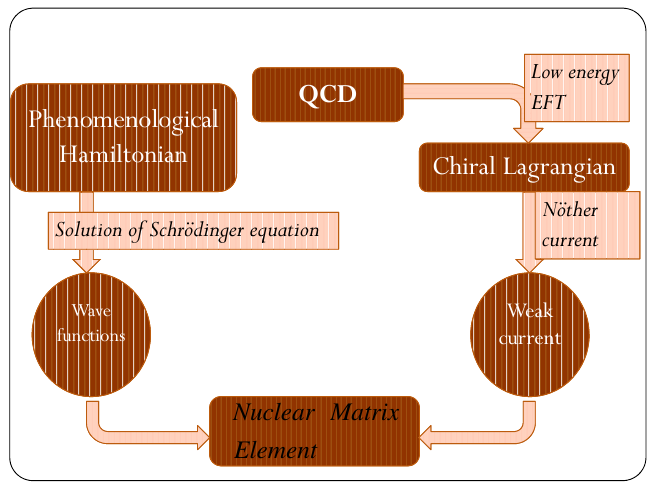
Fig. 5. A block diagram of the approach suggested by EFT* to calculate weak reactions